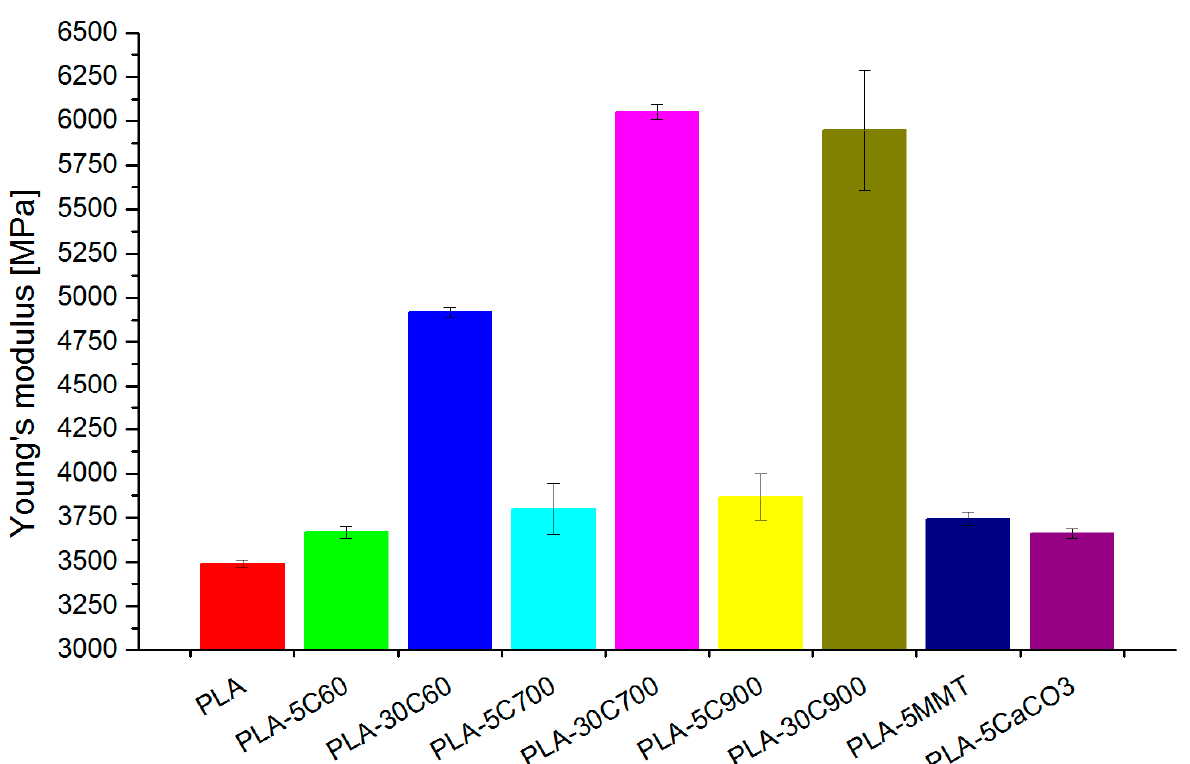
Figure 8. Young modulus—bending mode measurements.